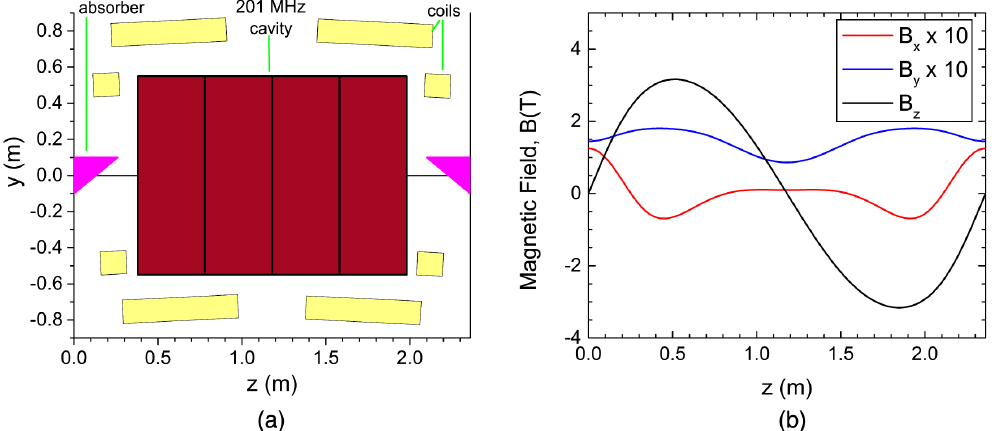
FIG. 2. (a) Side view of one cell for stage 2; (b) magnetic field on axis along the cell. The horizontal field B x is shown in red, the vertical field B y is shown in blue, and the longitudinal field B z is shown in